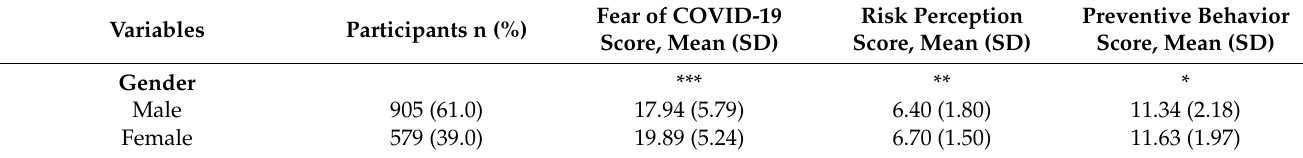
Table 1. Demographic distribution of the study population and comparison of mean scores of fear of COVID-19, risk perception, and preventive behavior by socio-demographic